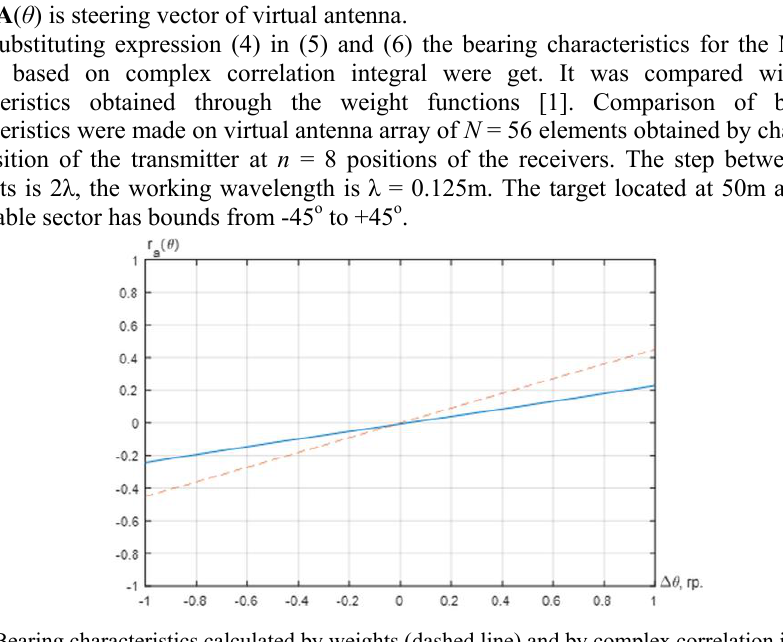
Fig. 1. Bearing characteristics calculated by weights (dashed line) and by complex correlation integral (solid